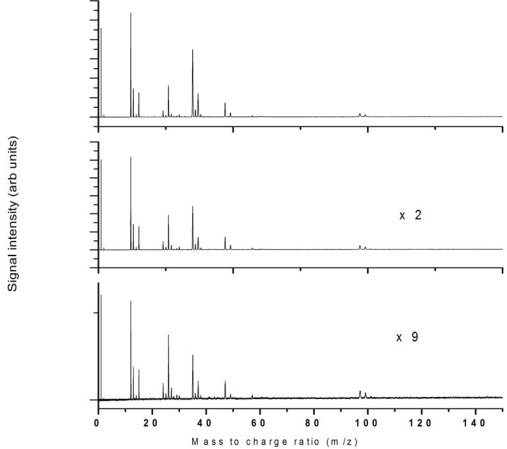
532 nm ionization at laser intensities (a) 2.8 × 1012 W/cm2, (b) 1.8 × 1012 W/cm2 and (c) 1.1 × 1012 W/cm2